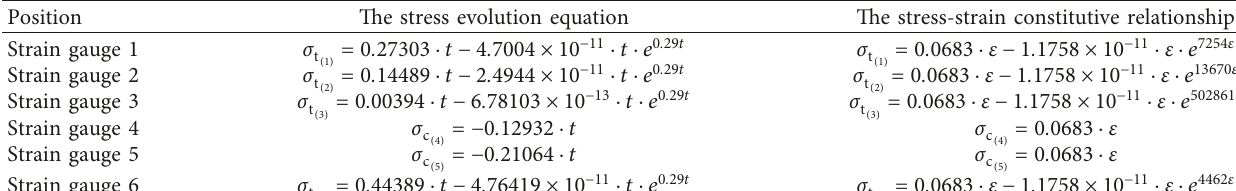
Table 6: The distance from the stress location to the bending neutral layer.